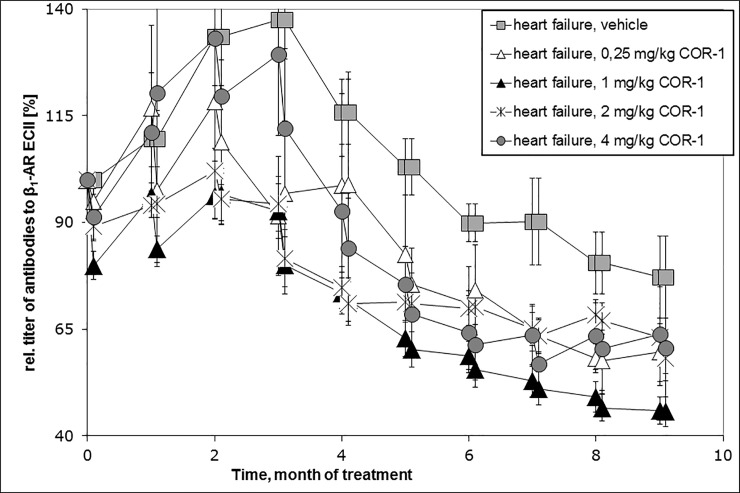
Anti-ß1EC2 antibody titersinduced by immunisation with GST-ß1EC2 fusion proteins.The time courses of the mean relative antibody titers after start of treatment as determined by ß1EC2 ELISA are shown for the HF vehicle group (grey squares, n = 9) and the COR-1 treatment groups receiving 0.25mg/kg (white triangles, n = 4), 1 mg/kg (black squares, n = 20), 2 mg/kg (black cross, n = 5), and 4 mg/kg BW COR-1 (grey circle, n = 9) as bolus injections, respectively. The respective data points are grouped to better visualise the titer courses, however, this does not mean that they reflect the real course between the data points. The black arrows mark time points of boosts (applications of GST-ß1EC2), the white arrows mark time points of treatment (COR-1 or vehicle). N = number of plasma samples from individual rats.Analysis of variance revealed no significant titer differences between the groups at start of therapy (12 months after the first immunization), but significant titer decreases in the groups treated with 1 and 4 mg/kg COR-1 compared to the HF vehicle group after 16 to 20 months of therapy. The titer decrease did not differ significantly between HF rats treated by vehicle compared to animals treated with 0.25 mg/kg and 2 mg/kg COR-1.